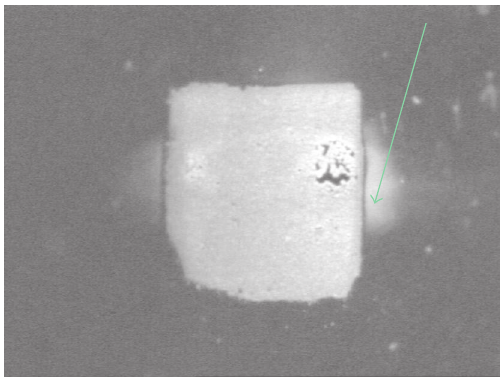
Figure 1: Collagen film surface after laser treatment ( F = 0 . 4 J/cm 2 , 30 pulses). Green arrow indicates a material deposition; black area represents nonirradiated region of the collagen of the collagen film. On the right in the irradiated spot, the surface ruptures are seen.